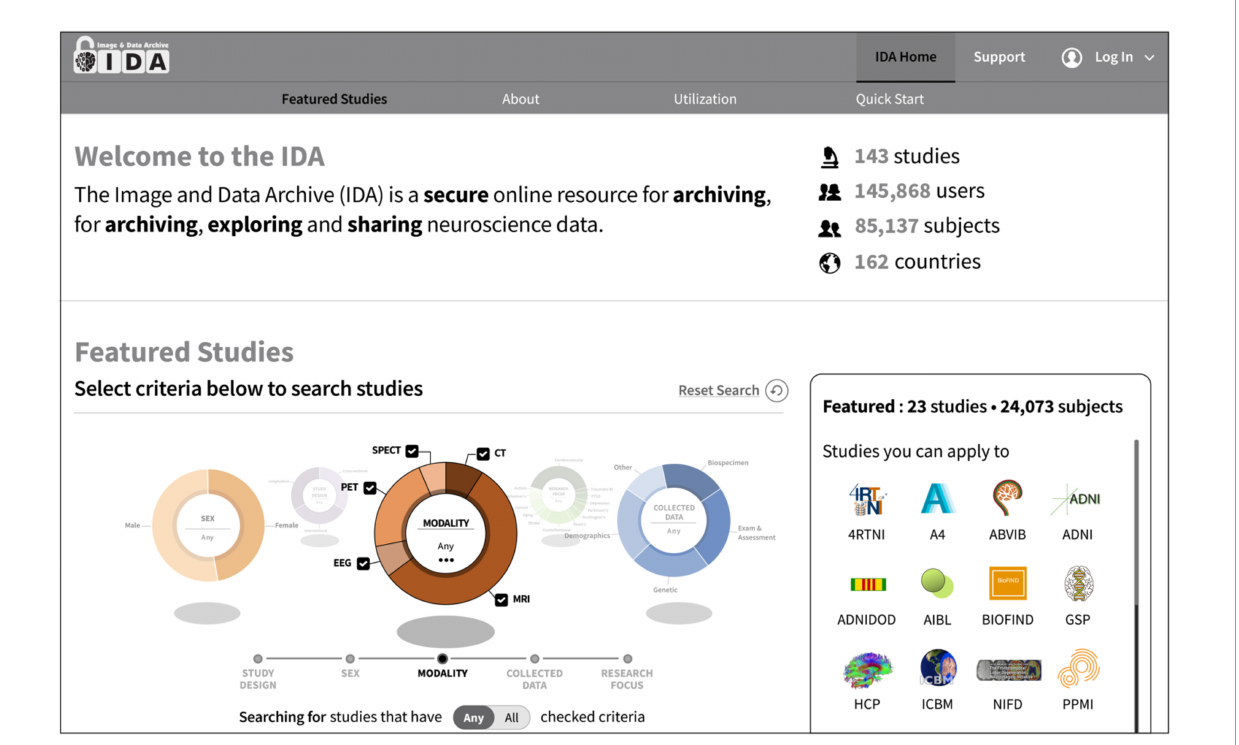
FIGURE1 The IDA manages more than 85,000 subjects from over 140 research studies and 270 institutions and receives new data daily. Users search for and apply to featured studies on the IDA home page by searching study criteria such as study design and research